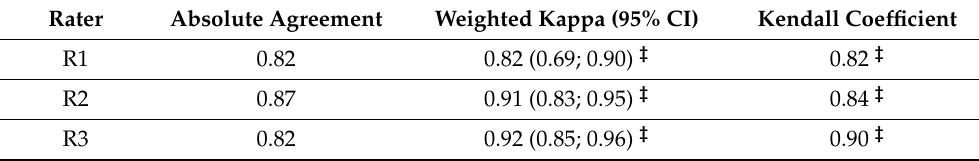
Table 3. Analysis of intra-rater agreement in the two study rounds.